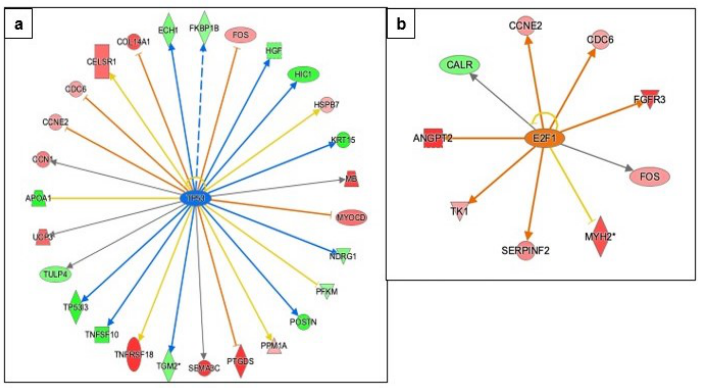
Figure 7. Effect of metformin on apoptosis and cell-cycle regulation as predicted by IPA. ( a ) IPA prediction of upstream regulators revealed that transcription factor TP53 is predicted to be inhibited by the downregulation of dataset molecules. ( b ) Transcription regulator E2F1 is predicted to be activated via upregulated dataset molecules. The key for the shape, color, direction and molecule types in the above pathways is provided in Figure